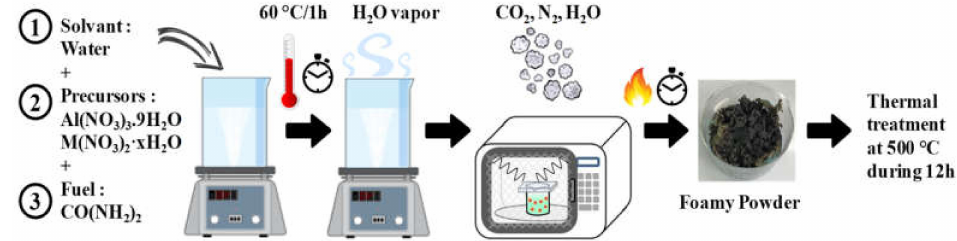
Figure1. Experimentalsetupusedforthesynthesisofbinaryoxidecatalyststhroughmicrowave-assisted solution